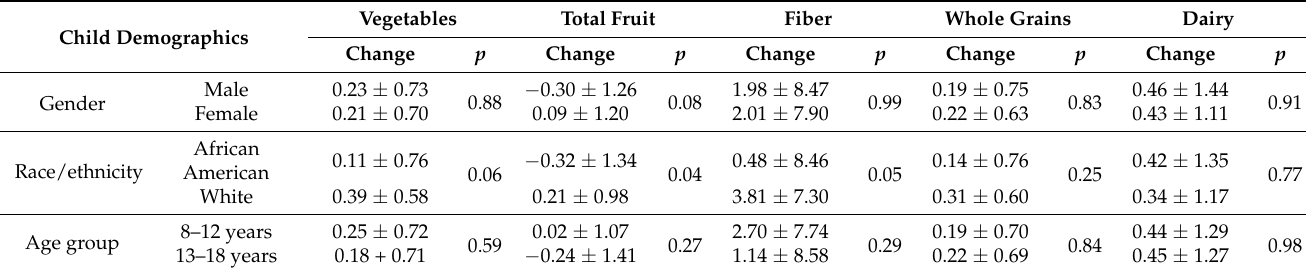
Table 3. Comparison of change in key dietary intake by child